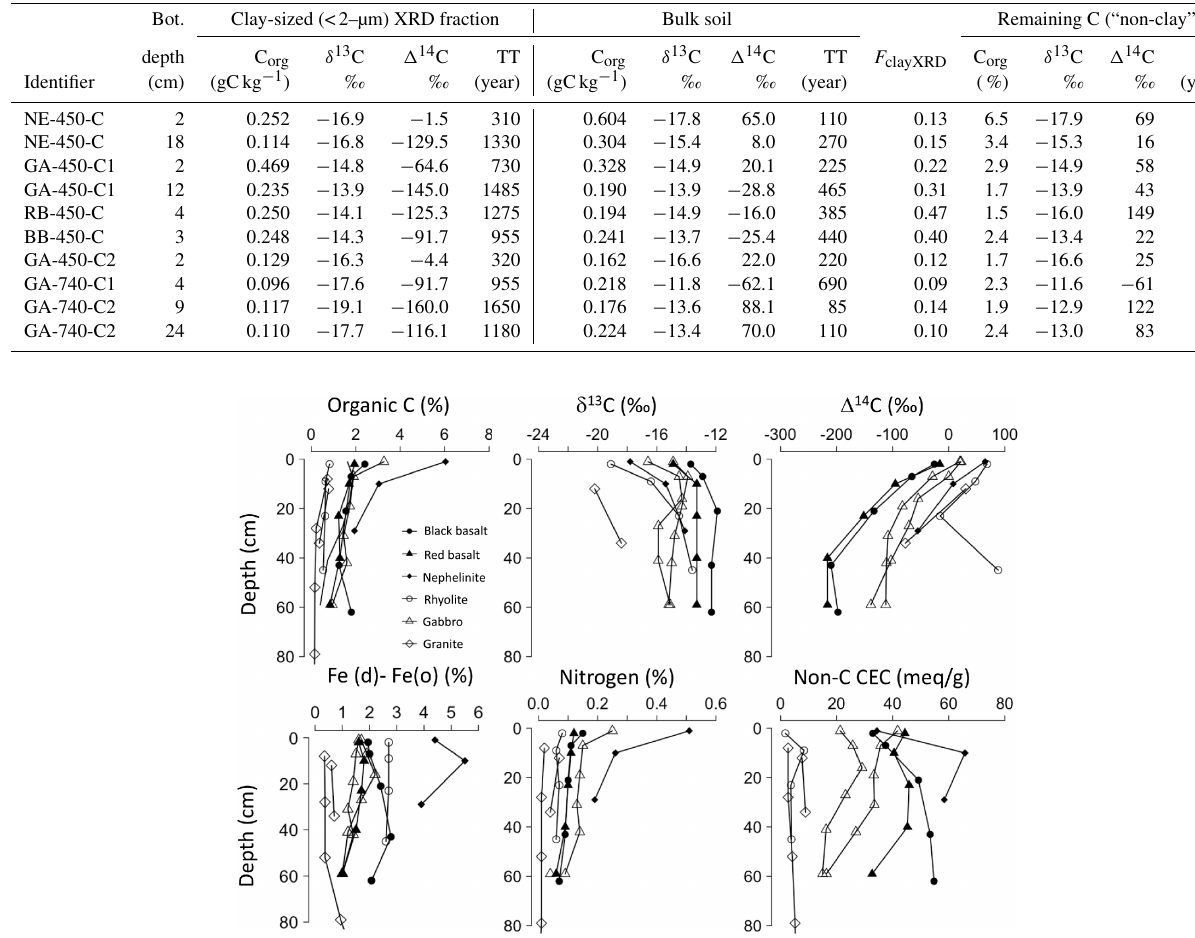
Figure 3. Depth profiles of bulk C (top-left), δ 13 C (top-middle), and (cid:49) 14 C (top-right) measured in bulk C for soil profiles developed on selected lithologies. Also shown in the lower panels are other soil bulk properties, total Fe oxyhydroxides (Fe(d)–Fe(o)) (bottom-left), total nitrogen (bottom middle), and cation exchange capacity (CEC) corrected for organic matter contributions (bottom right; see